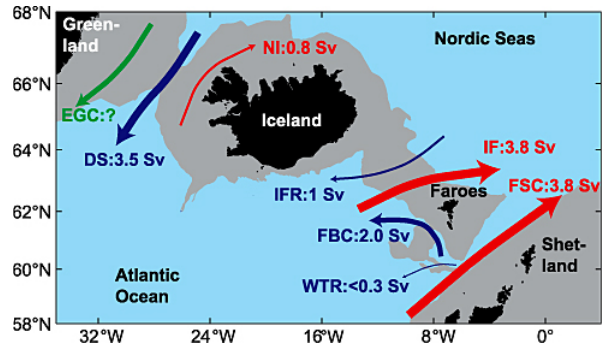
Fig. 13. Exchanges between the Nordic Seas and the Atlantic Ocean. Red arrows indicate Atlantic inflow to the Nordic Seas. Blue arrows indicate overflow, The green arrow indicates the surface-near outflow of the East Greenland Current. Volume trans- ports are for the 1999–2001 period for the Atlantic inflow (Østerhus et al., 2005), for the DS-overflow (Macrander et al., 2005), and for the FBC-overflow (Hansen and Østerhus, 2007). For the two other overflow branches, typical values from the literature (Østerhus et al., 2008) are shown. The volume transport of the East Greenland Current is difficult to measure and not well known.